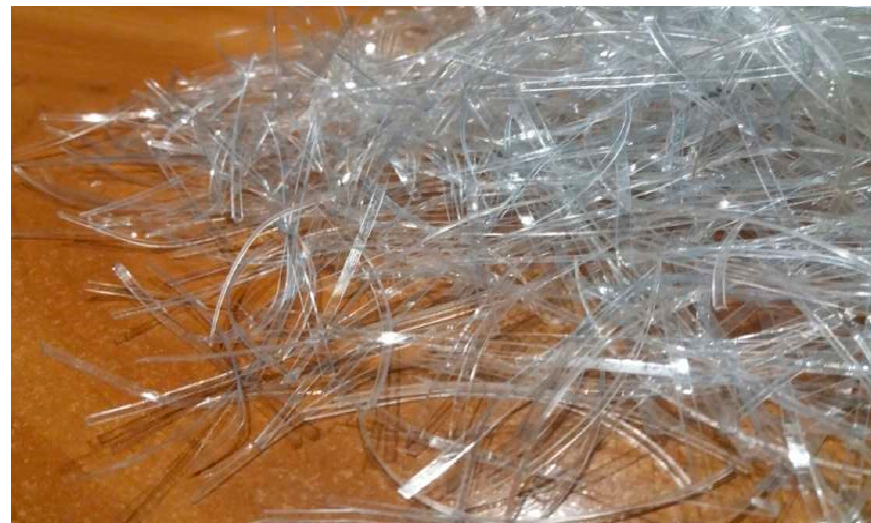
Figure 2. Recycled PET fibres cut from beverage bottles.